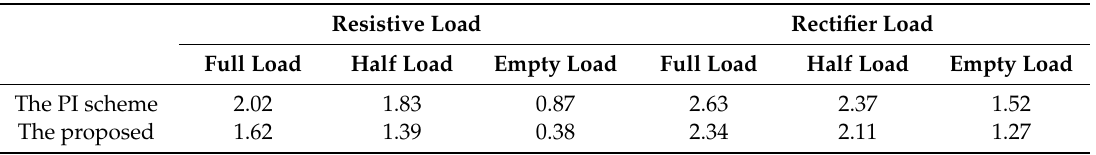
Table 2. Output voltage total harmonic distortion (THD) comparison between the PI scheme and the proposed scheme.